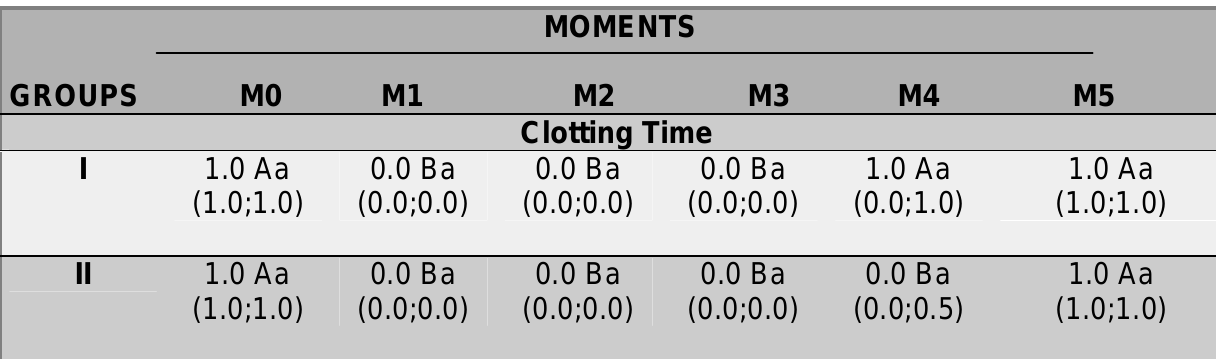
Table 4: Means of clotting time according to groups and